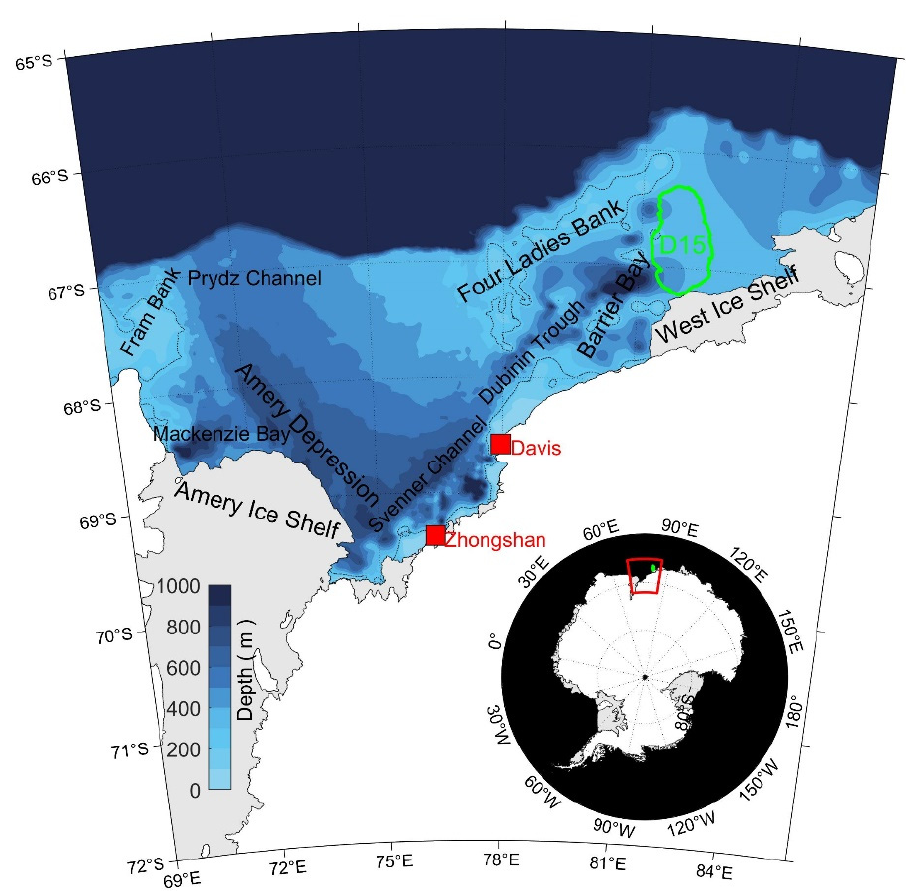
Figure 1. Bathymetry of Prydz Bay from Rtopo2 [13]. The thick green line is the outline of the giant grounded tabular iceberg D15. The red squares denote the research stations. The inset in the lower right corner shows the location of the study area.